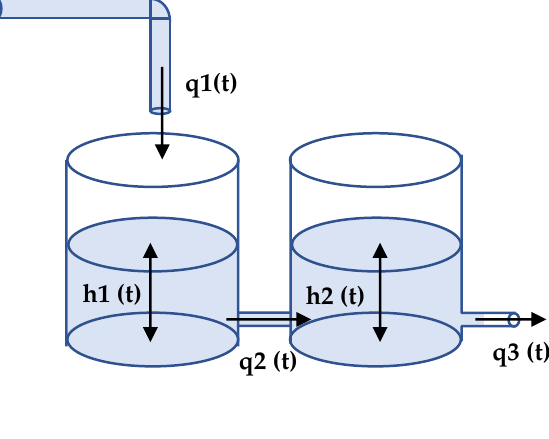
Figure 1. First plant (SISO